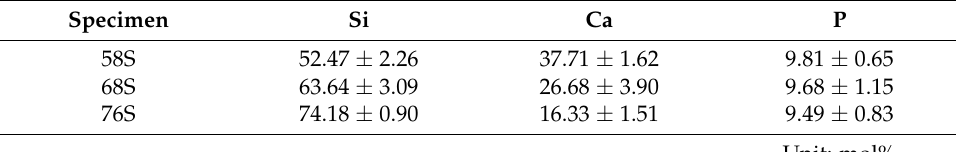
Table 1. Atomic compositions of 58S, 68S and 76S BG powders derived from EDS spectra.